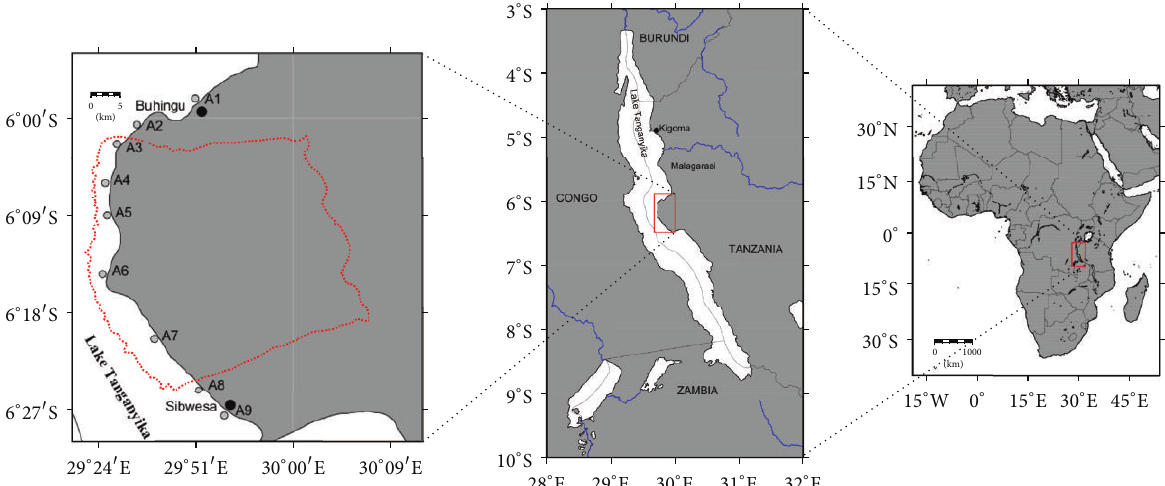
Figure 1: Map of Lake Tanganyika showing study sites within protected area (MMNP: A3–A7) and in unprotected areas (Buhingu: A1-A2 and Sibwesa: A8-A9) during 2008 gillnet survey. The large red polygon in the first frame shows sketch boundaries of MMNP (terrestrial and water strip in grey color and white color, resp.). The blue lines in the middle frame represent